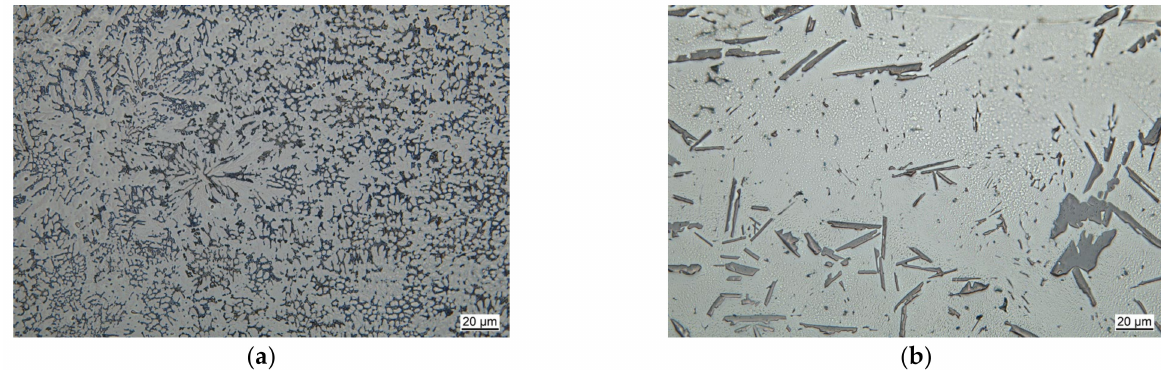
Figure 11. Weld bead of AlMg3 with ( a ) Fe particles and ( b ) Co